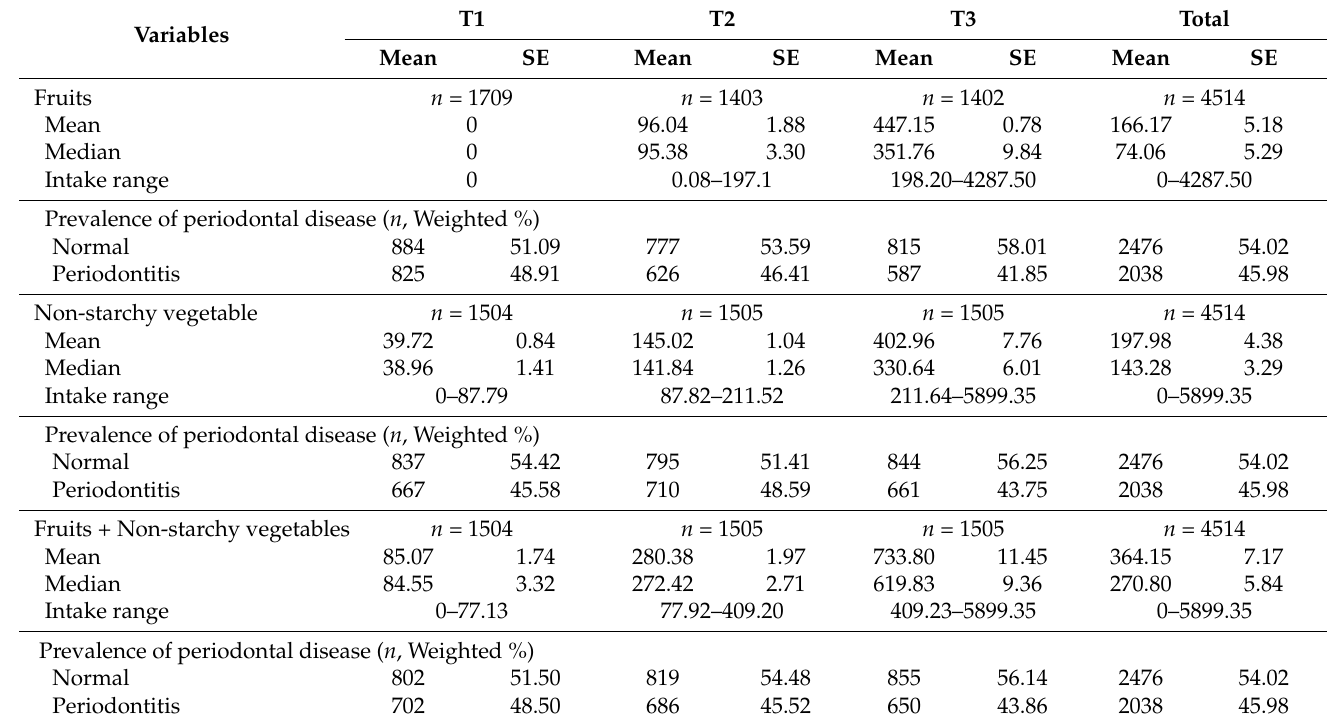
Table 7. Prevalence ratio of periodontal disease by their tertile and intake range of plant